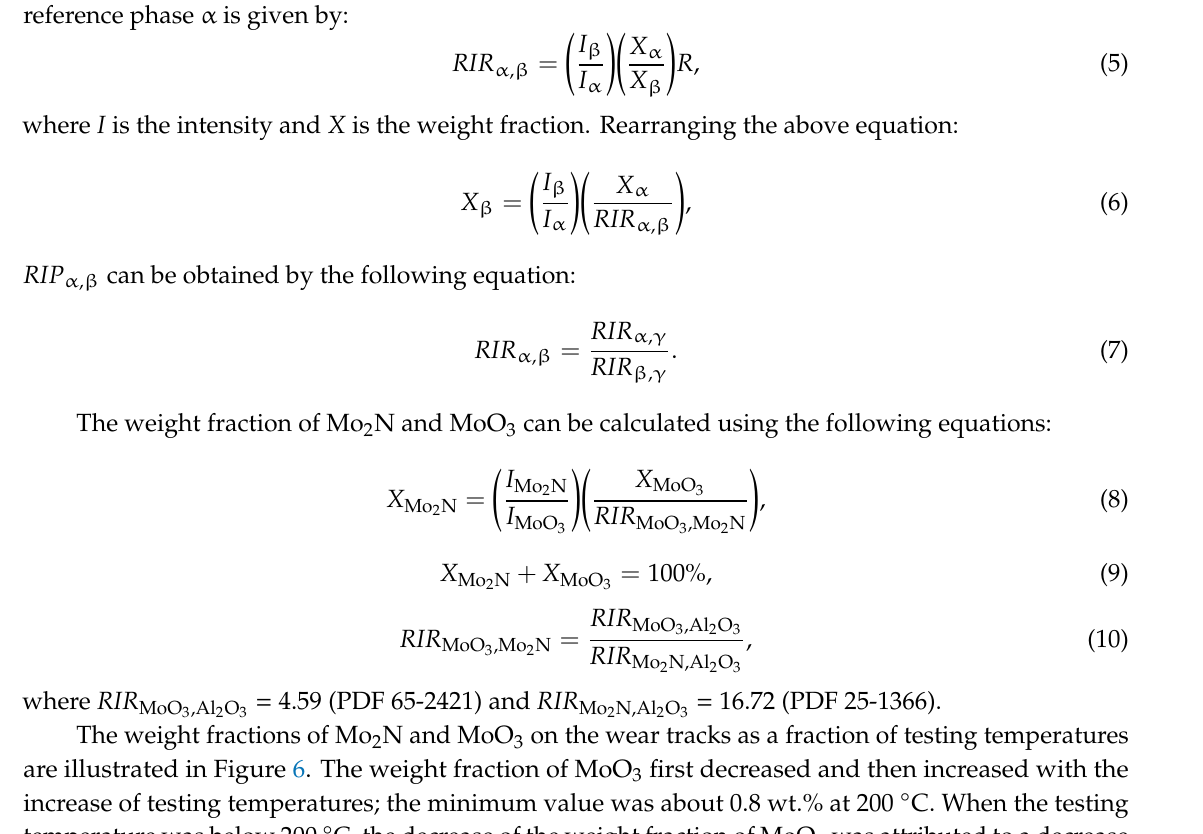
Figure 5. Patterns of wear tracks at different testing temperatures.